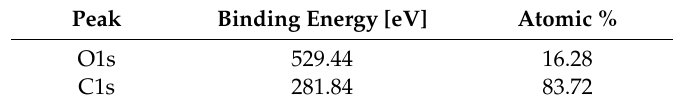
Table 3. Binding energy and atomic percent of refined linseed oil, as shown by XPS (Figure S3).